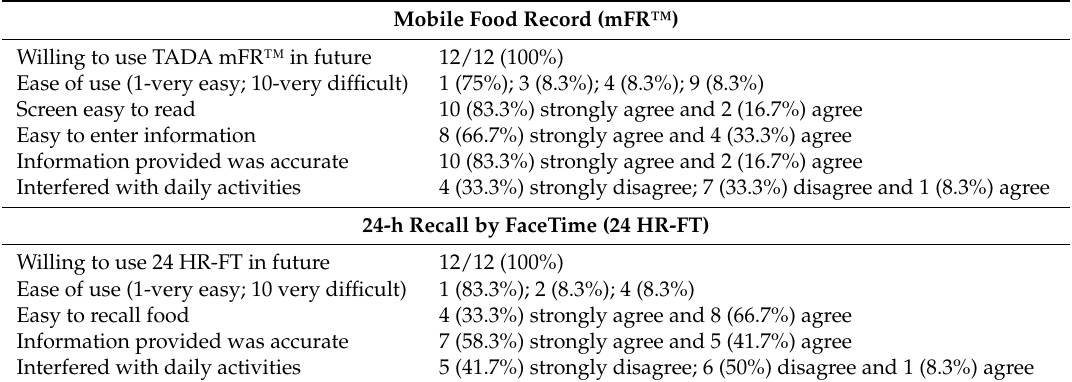
Table 1. Child post-study survey